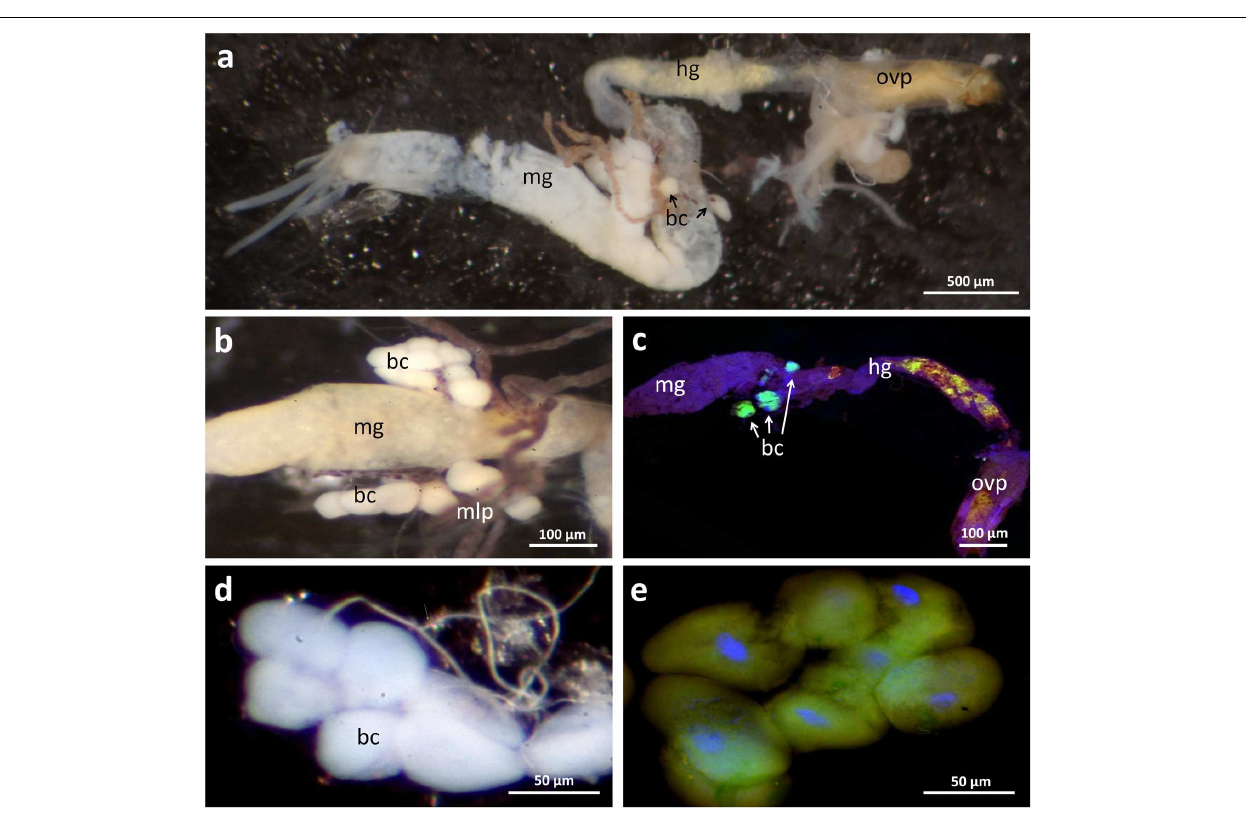
FIGURE 2 | Localization of bacteriomes associated with the digestive tract and the Malpighian tubules in Dasytes virens. (a) Overview image of the dissected digestive tract. (b) Close-up of the bacteriomes located at the posterior end of the mid-gut. (c) Whole mount in situ hybridization micrograph on